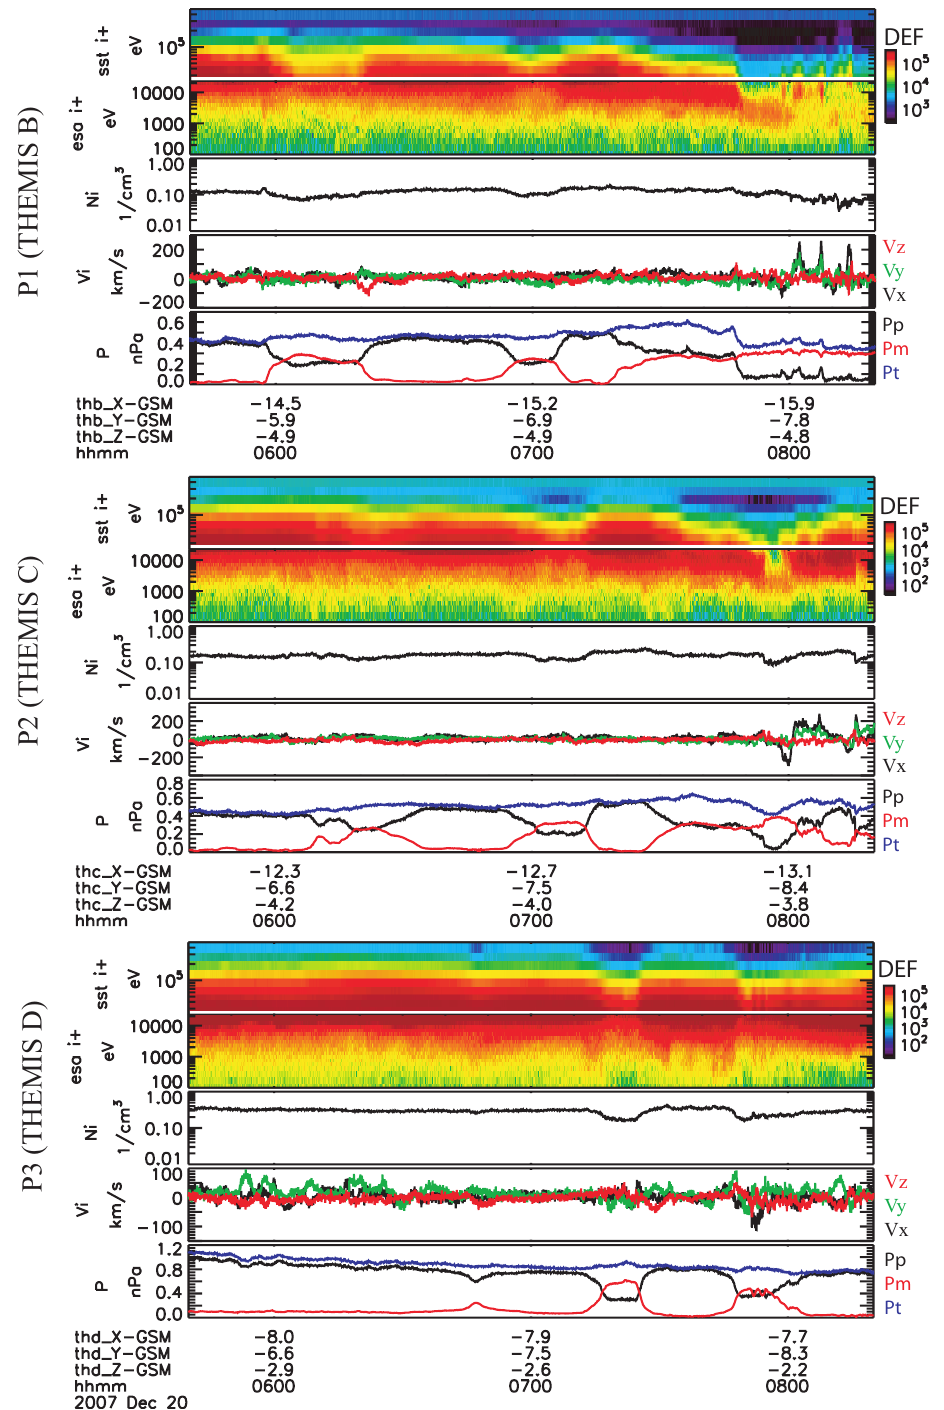
Fig. 5. Ion energy-time omnidirectional spectrograms from SST ( W> 25keV) and ESA (0.01 <W< 25keV) instruments, the ion number density, GSM components of the ion bulk velocity, magnetic, plasma and total pressures at THEMIS P1, P2, and P3 during 05:40–08:20UT. The moments are calculated from joint ESA and SST